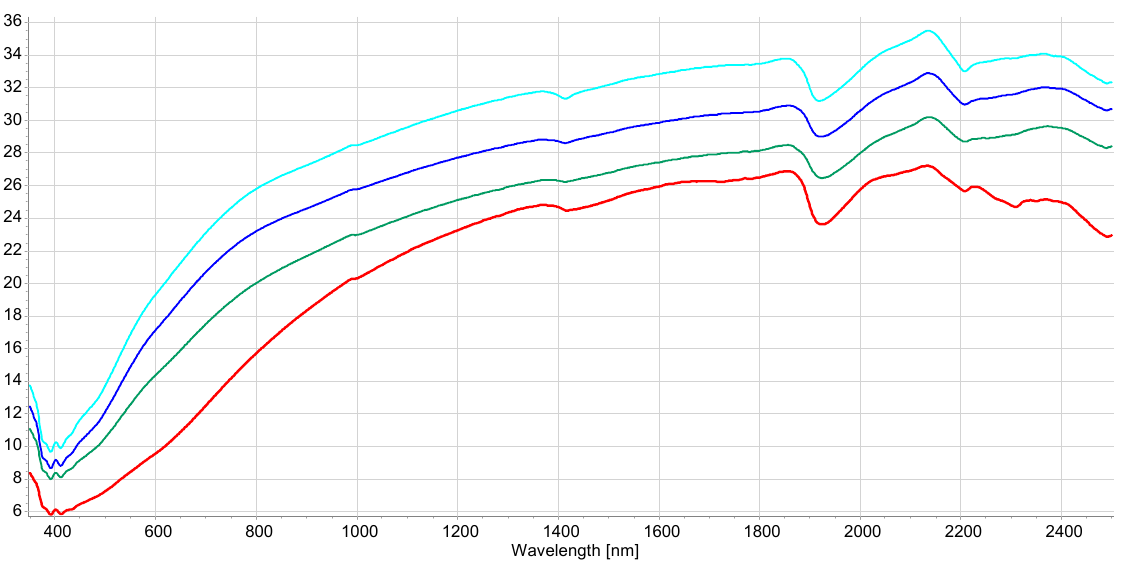
Figure 1. Mean reflectance spectra for the soil class texture. Red—muck samples, green—sand, light blue—sandy loam, dark blue—loamy sand (according to USDA classification).